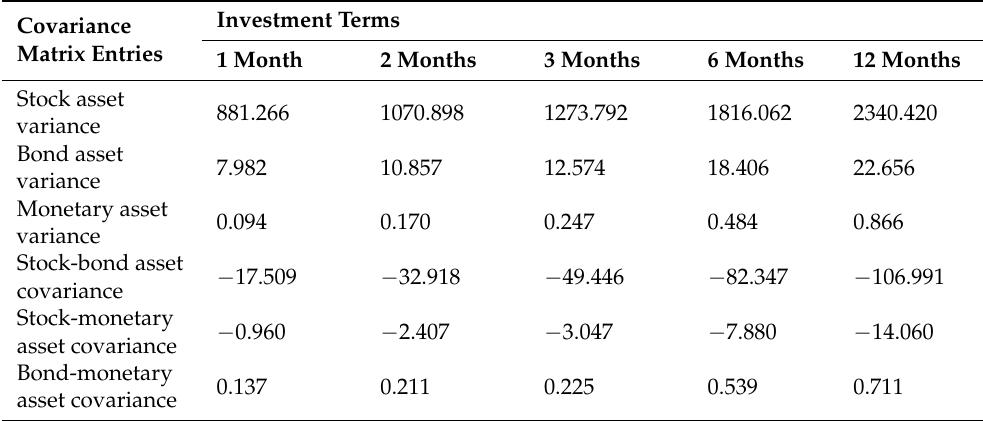
Table 3. The annualized covariance matrices for stock, bond, and monetary assets under differ- ent